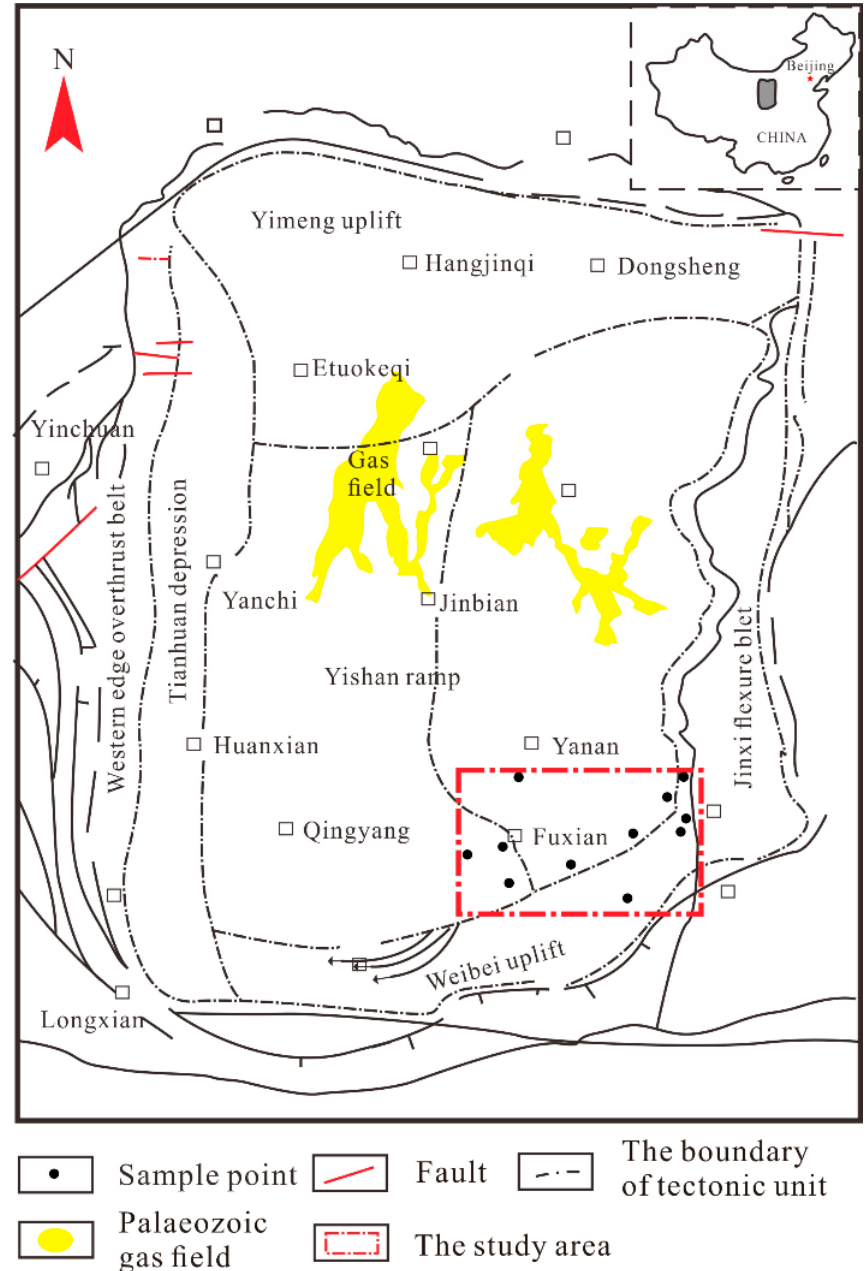
Figure 1. The location map of study area.